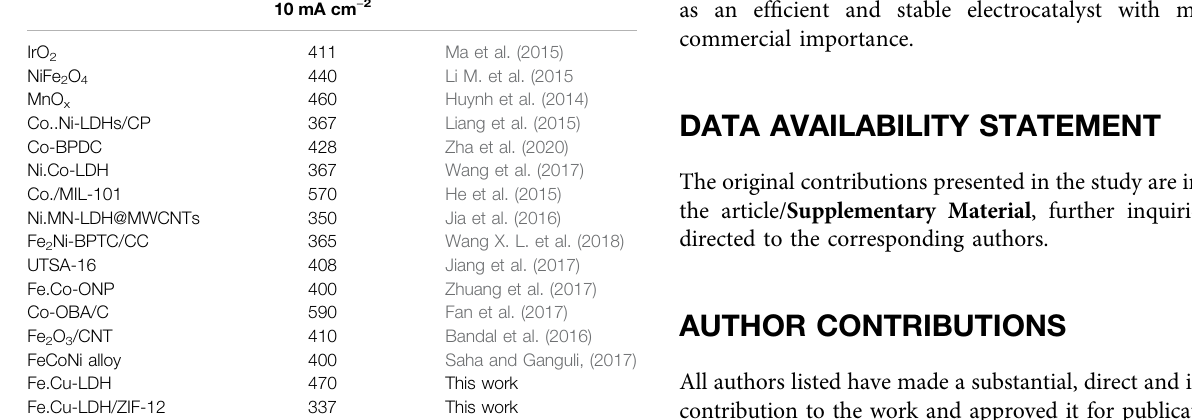
TABLE 1 | Comparative analysis of different reported benchmark electrocatalysts with composite 1.